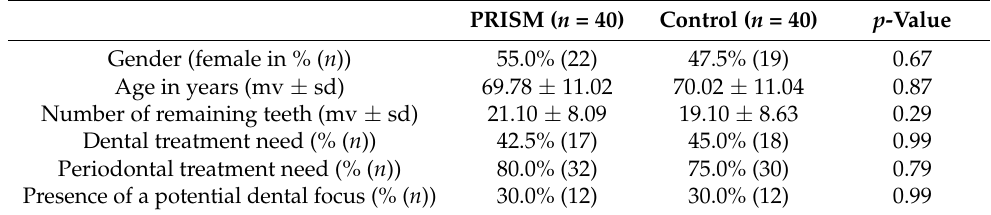
Table 4. Characteristics of participants who received the education either by PRISM (PRISM group) or verbally using a flyer (Control group) during observational